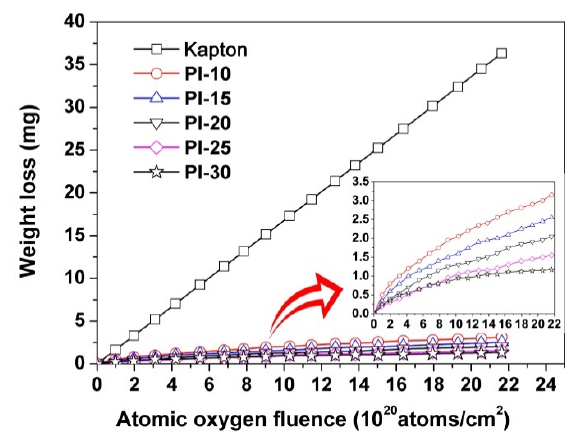
Figure 10. Weight loss of POSS-PI films during atomic-oxygen (AO) erosion (AO fluence: 2.16 × 10 21 atoms / cm 2 ). Table 3. AO e ff ects and erosion yields for POSS-PI films.